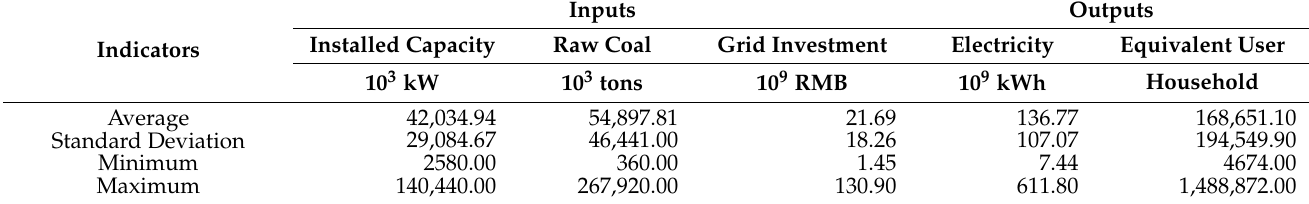
Table 3. Descriptive statistics of production variables from 2006 to